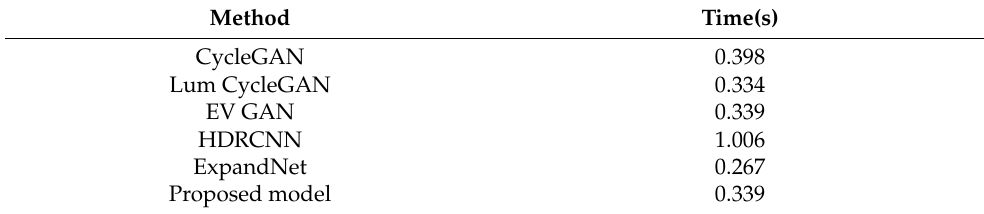
Table 1. Computational time needed for each